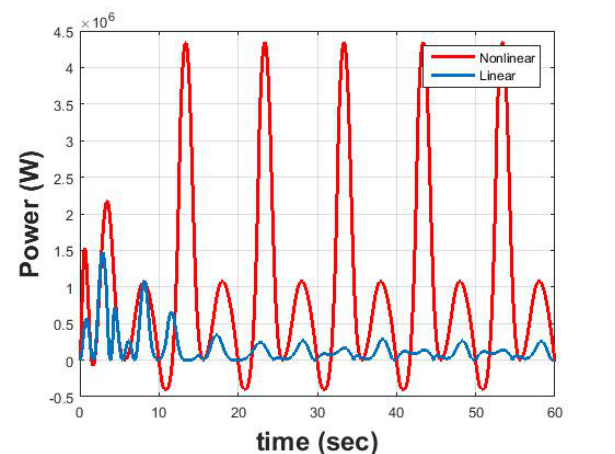
Figure 9. Comparison between the linear and nonlinear WECs in a regular wave: power extracted.